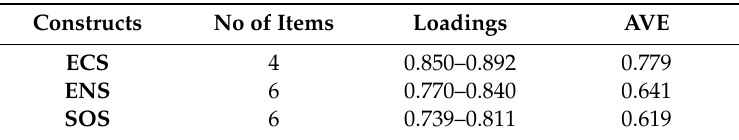
Table 4. Convergent